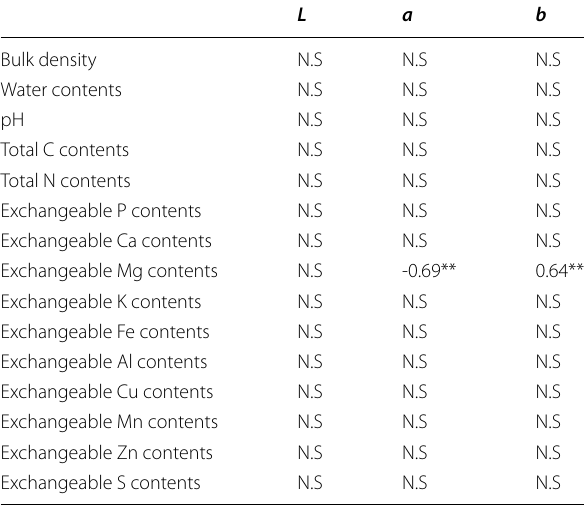
L value is for luminescence that represents the position on the black–white axis, a value that defines the position on the red–green axis, and b value that defines the position of the yellow–blue axis (see the details in Material and Method section). The number in the table is D values calculated based on D 2 value by [3]. Asterisk (**) show the statistically significant relationship ( p < 0.01) determined by GLM